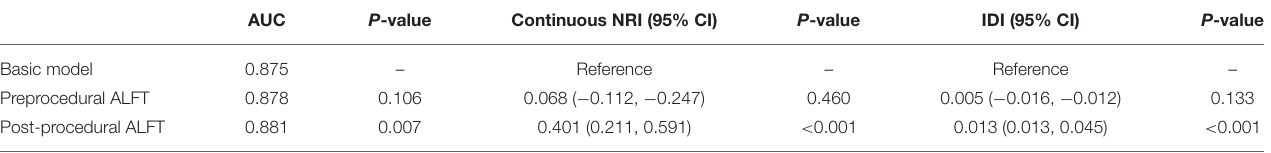
TABLE 3 | Comparison of basic models and models adding ALFT for predicting favorable prognosis and excellent prognosis.